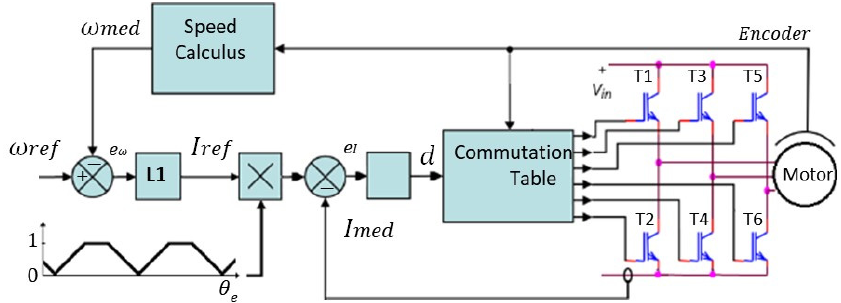
Figure 7. Control loop with current imposition .